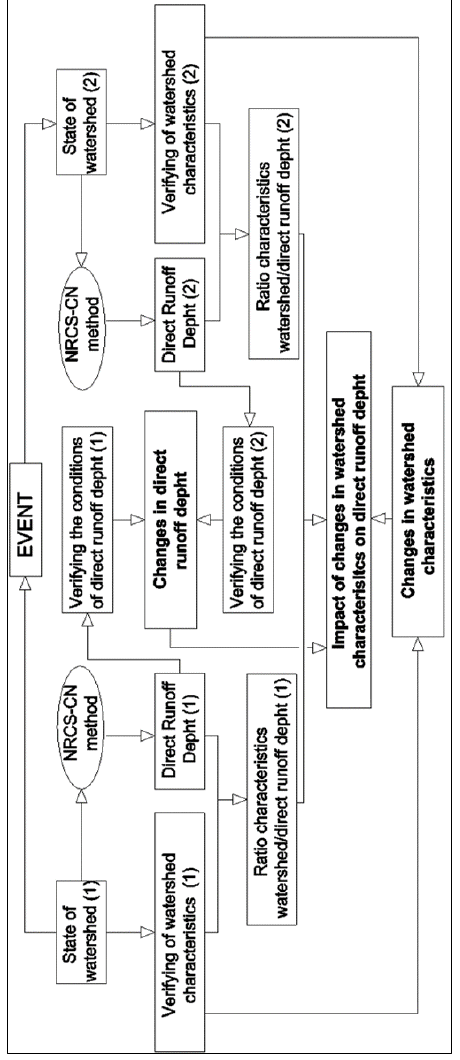
Figura 1: the fluxogram for verification of changes in watershed characteristics and impact on